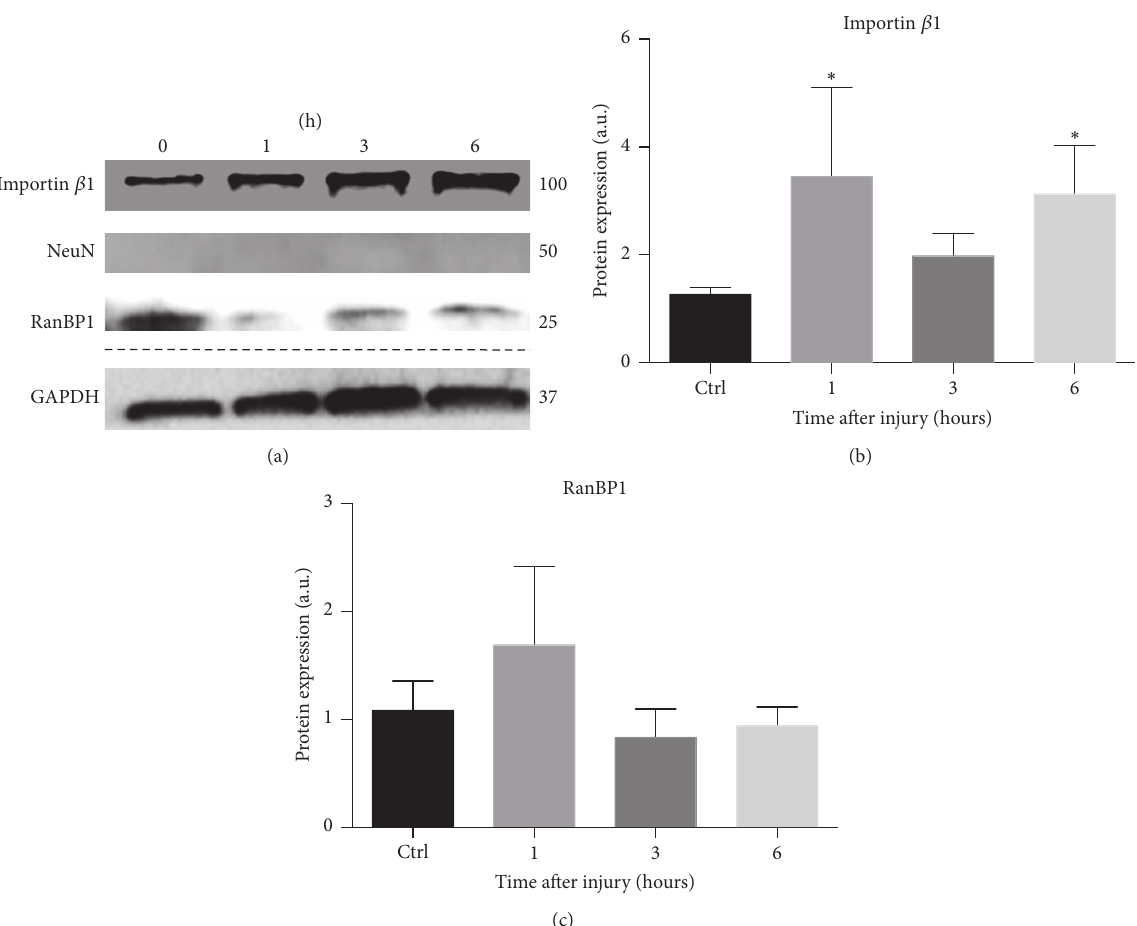
Figure 4: Importin 𝛽 1 protein levels are significantly increased at 1 and 6 hours of injury. (a) Representative Western blots of several RIS- associated proteins (normalized to GAPDH). Note that GAPDH levels vary slightly across time points. Western blots also indicate exclusion of NeuN protein from axonal population. (b) Quantification of relative importin 𝛽 1 protein expression. (c) Quantification of relative RanBP1 proteinexpression.Dataarerepresentedasmean ± SEM.Effectoftimeonexpressionwasassessedusingone-wayrepeatedmeasuresANOVA, and mean values at each time point were compared to control post hoc using Dunnett’s test. ∗ indicates significant difference from control ( p < 0.05); untransformed data are plotted; however, values were reciprocally transformed prior to ANOVA testing, to meet the requirement of normality. Transformed values are shown in Table